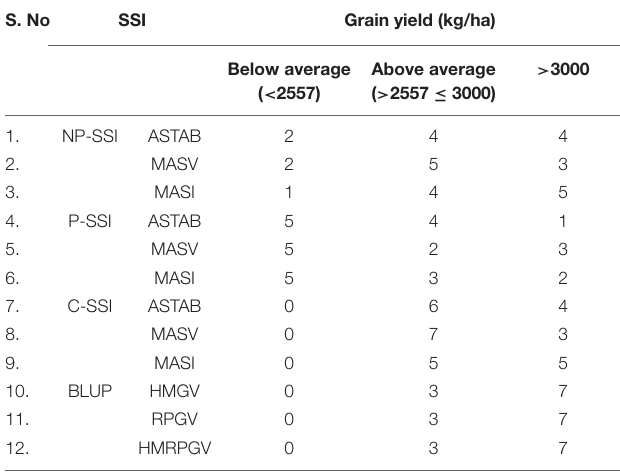
TABLE 6 | Number of genotypes with high ( > 3,000 kg/ha), below ( < 2,557 kg/ha), and above-average ( > 2,557– ≤ 3,000 kg/ha) grain yield among top ten entries selected through various stability